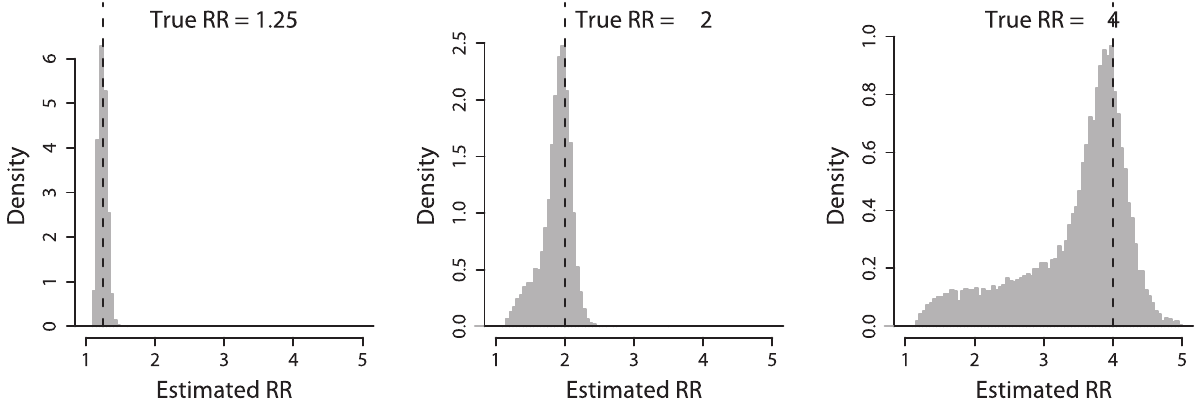
Figure 1. Distribution of estimated effect sizes. Histograms of estimated relative risks (RR), for three different true relative risks indicated by a vertical dashed line in each plot. Histograms include all simulations where the most associated (hit) SNP was significant in both the initial study and the replication study.